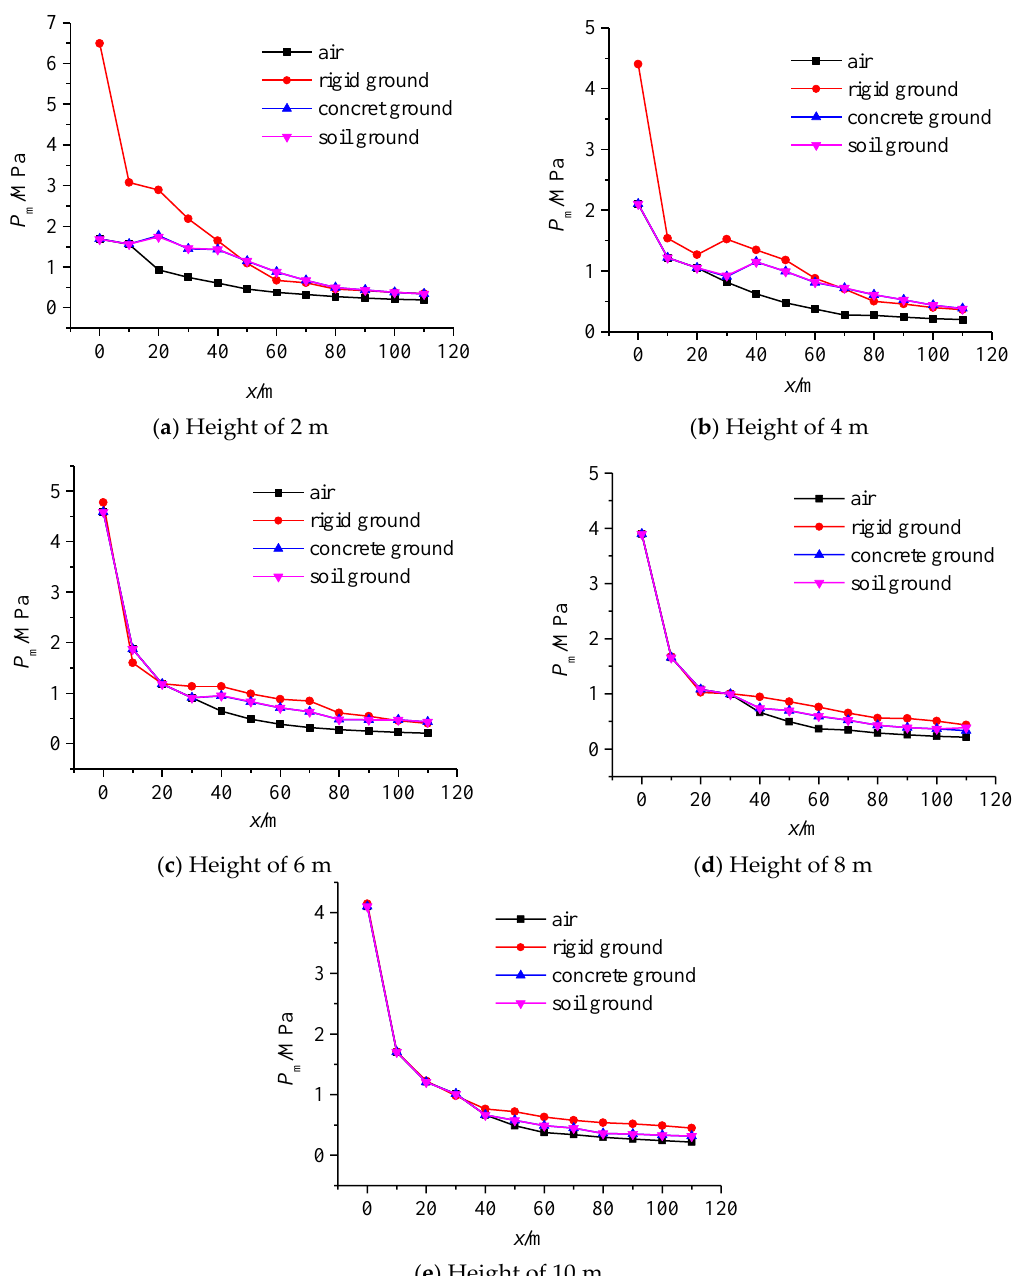
Figure 11. Distribution of peak overpressure of gauges at different height produced by explosion on different ground.